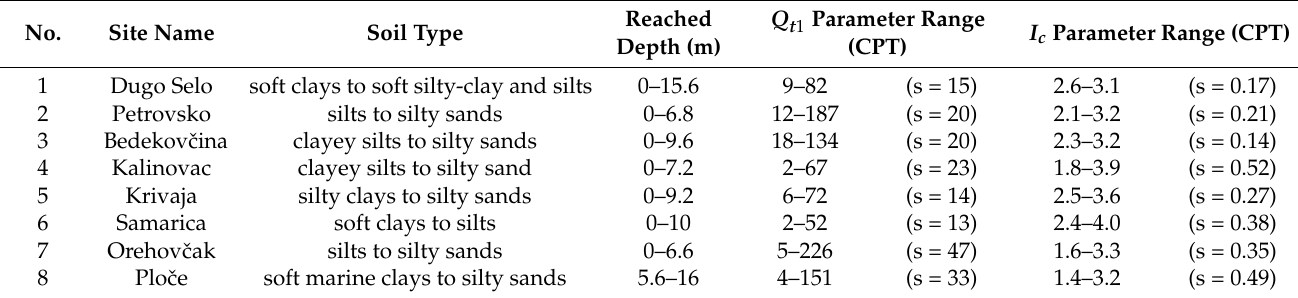
Table 3. List of study sites including measured CPT profiles